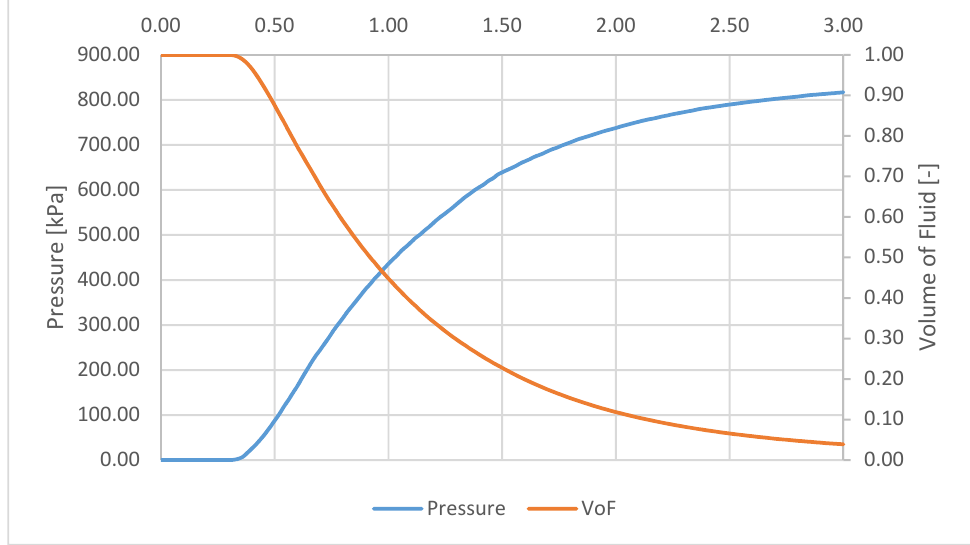
Figure 10. Relation between volume of fluid inside skin blister and pressure inside.